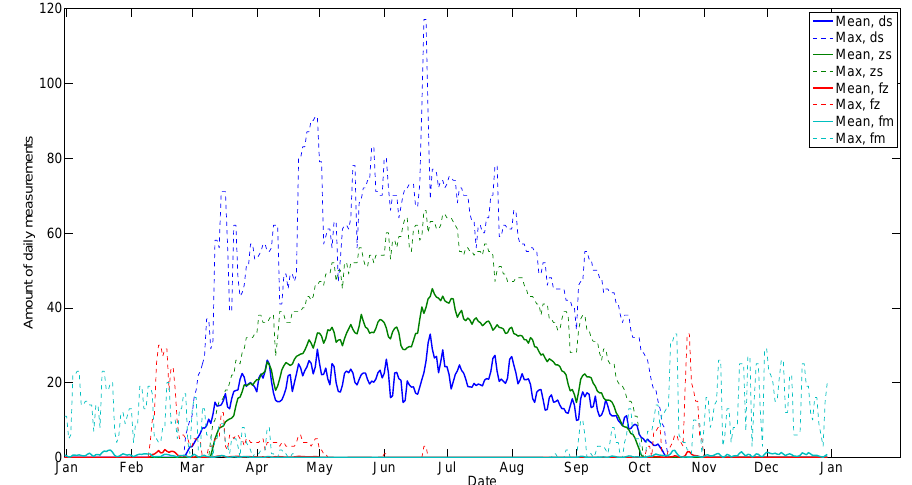
Figure 5. The seasonal variability of the amount of measurements. Solid lines represent the mean amount of measurements of each type for each day of the year. The maximum amount for any year for this certain day of year has been plotted in dashed lines in the color representing the measurement